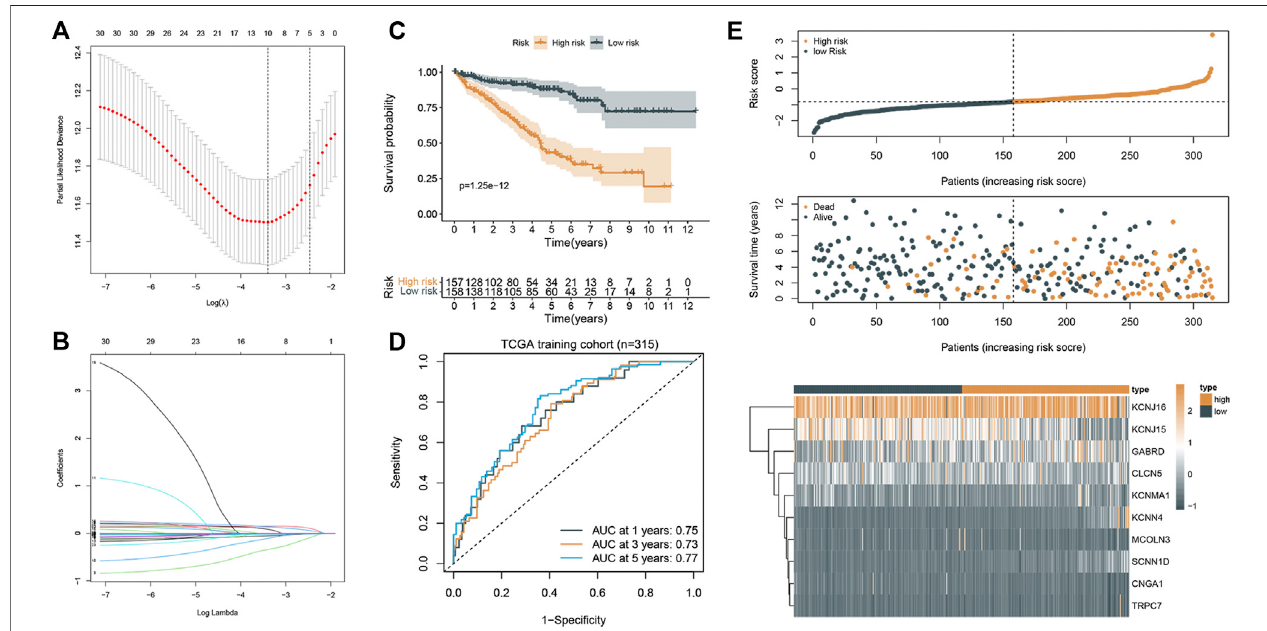
FIGURE 6 | Construction and validation of the prognostic signature. (A) Cross-validation of the parameter selection in the LASSO regression. (B) LASSO regression of the 10 ICRGs related to the OS. (C) Kaplan – Meier survival curves between high- and low-risk groups ( p < 0.001). (D) ROC curves of the prognostic signature for predicting 1-year, 3-year, and 5-year OS in TCGA cohort. (E) Signature gene expression patterns and the distribution of survival status and risk score in TCGA training cohort.